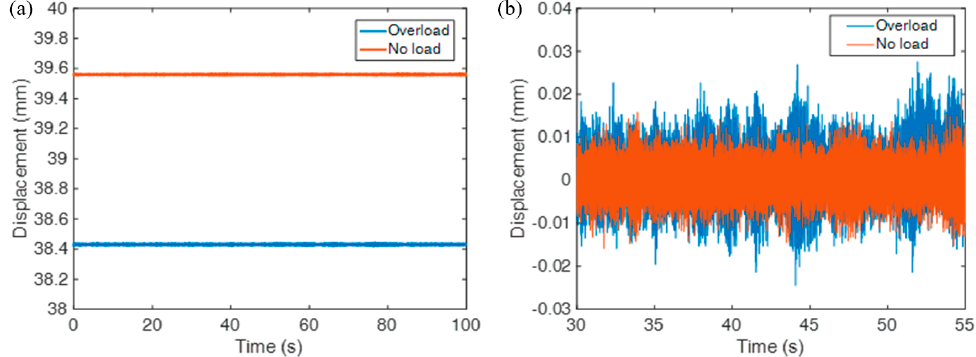
Figure 11. Effect of load on the vertical deflection of the bridge: ( a ) absolute displacement and ( b ) relative displacement.